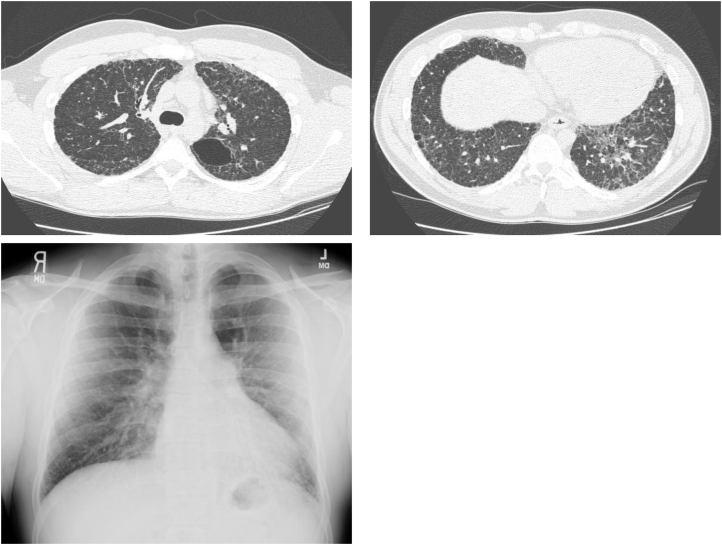
Chest CT and X-rays, patient age 27 years.